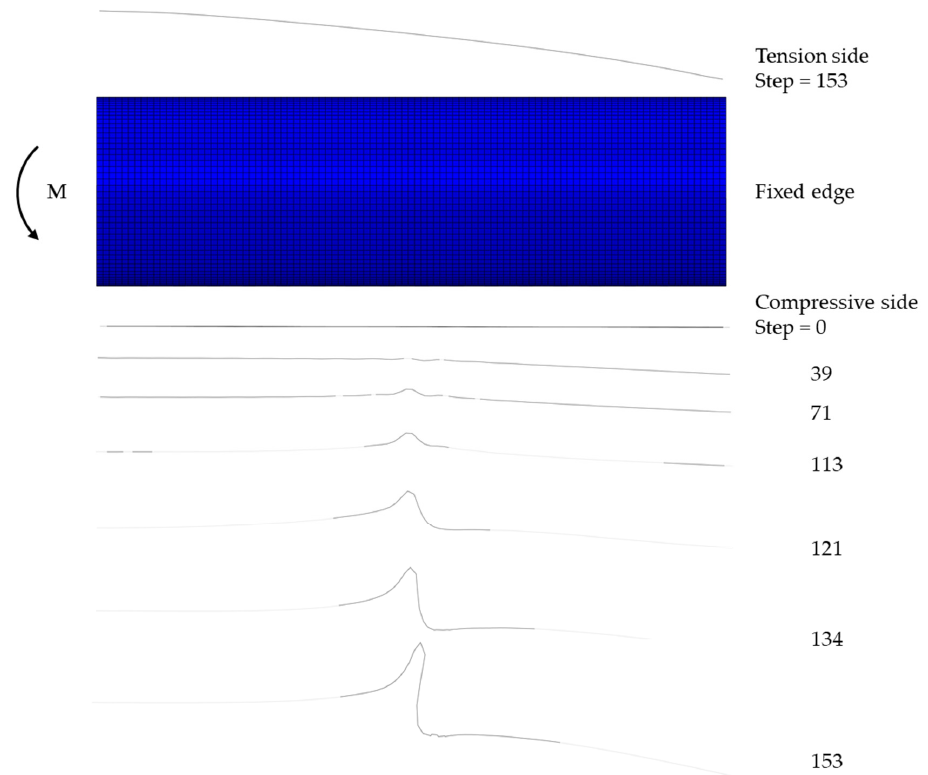
Figure 14. Shell (20 m at 24 mm) longitudinal surface displacement under the bending moment (scale factor =